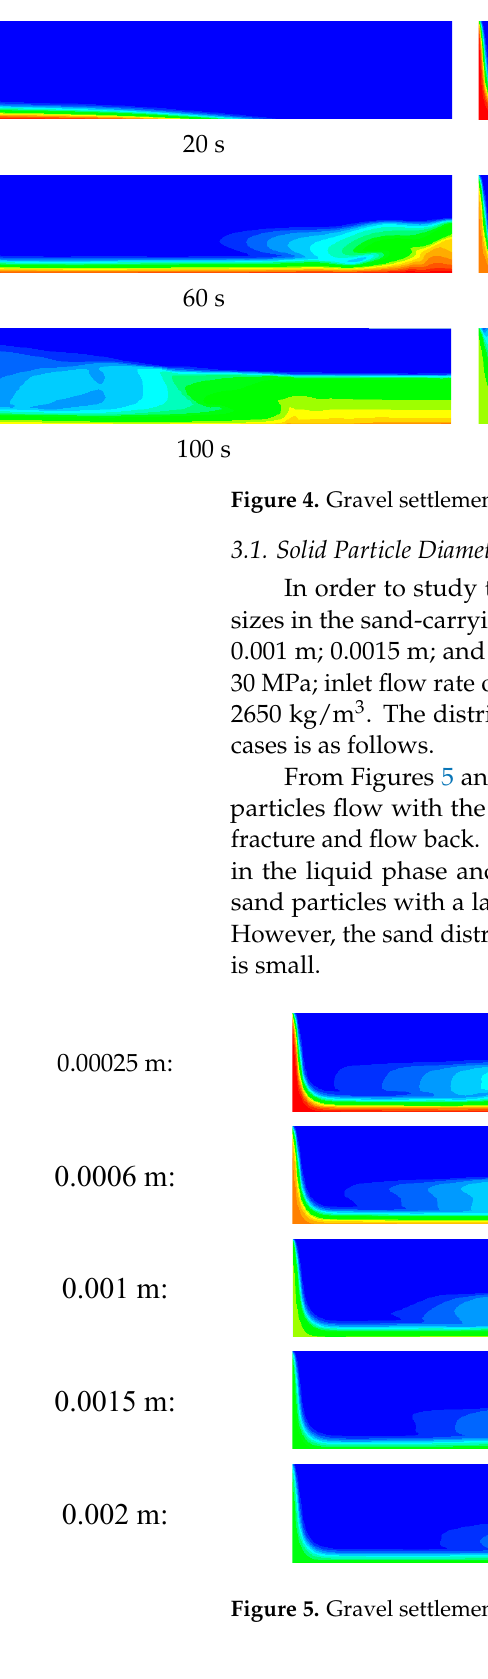
Figure 6. Settling time at different particle diameters. 3.2. Fluid Velocity In order to study the sedimentation characteristics of solid particles under different sand-carrying and solid-phase particle flow speeds, we set five different inlet velocity sizes: 0.5 m/s; 1 m/s; 1.5 m/s; 2 m/s; and 2.5 m. The flow conditions were temperature: 60 °C; pressure: 30 MPa; solid particle diameter: 0.0006 m; sand concentration: 0.4; sand den- sity: 2650 kg/m 3 . The sand distribution after 80 min in the five cases is as follows. It can be seen from Figures 7 and 8 that the fluid velocity has a significant effect on the sedimentation characteristics of solid particles. When the flow rate is low, the flow of sand-carrying fluid and sand is relatively stable, and sand is more prone to sedimentation. A lot of gravel does not reach the end of the crack and is deposited at the bottom. At high flow rates, most of the sand will be deposited by hitting the trailing edge of the fracture, and eventually the sand will be more evenly distributed. As can be seen from Figure 8, it 80100120